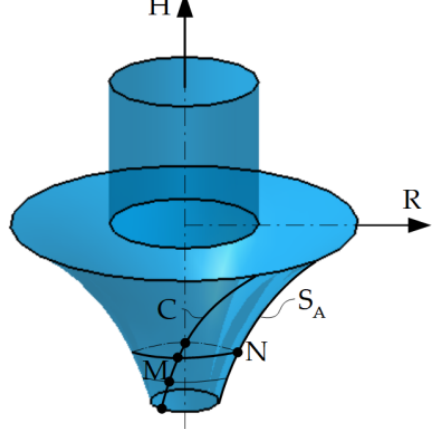
Figure 17. The axial section of the finger cutter tool.